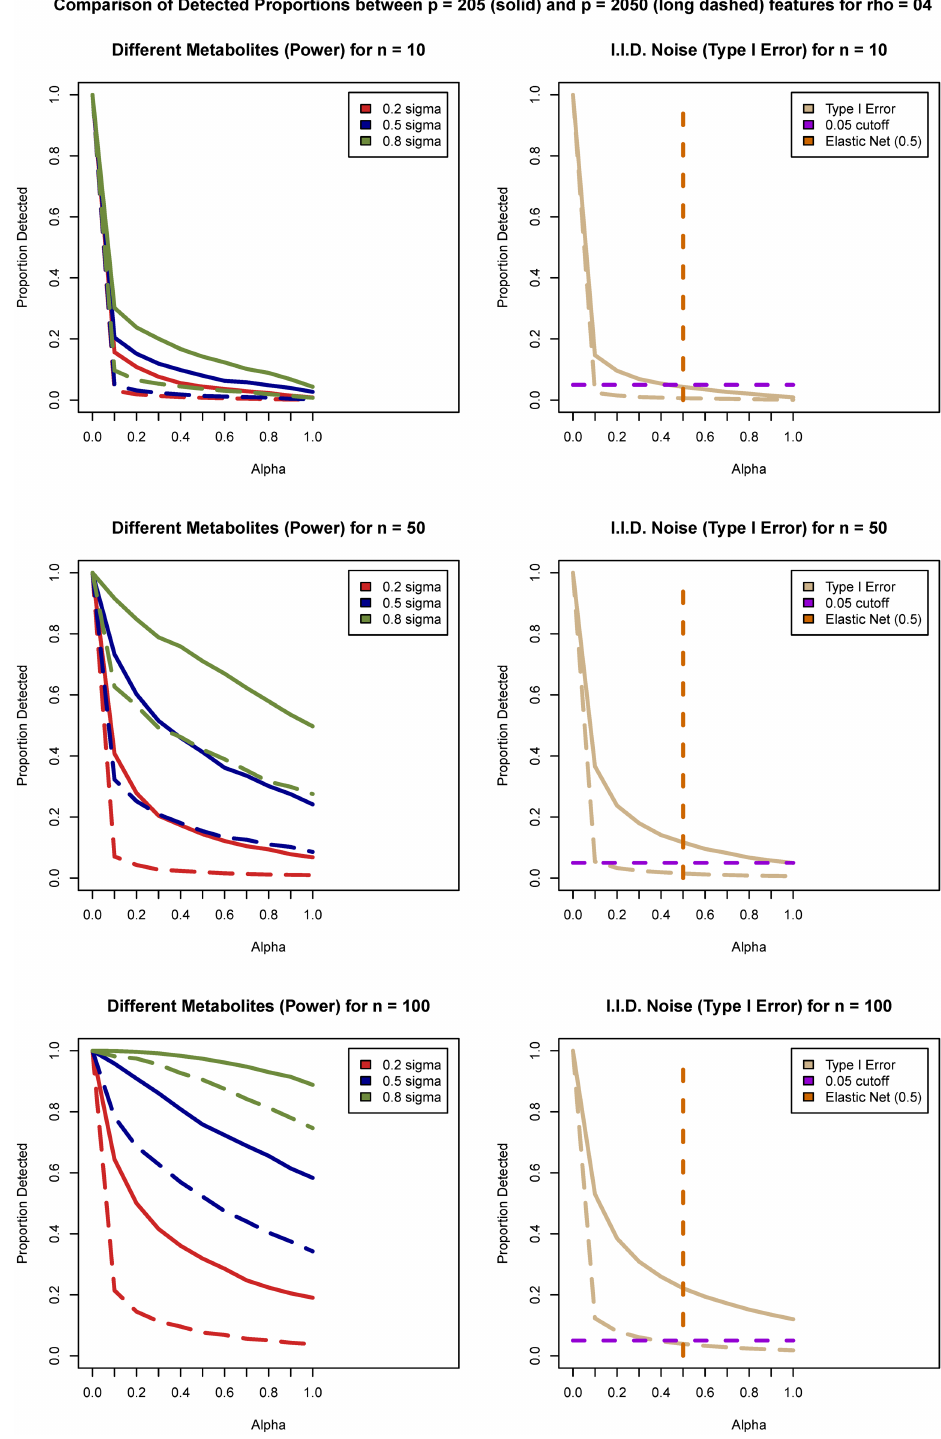
Fig 2. Visualization of power (left column) and Type I error (right column) estimates. Comparison between p = 205 (solid lines) and p = 2050 (dashed line) features for ρ = 0.8 and sample sizes n = 10 (top row), n = 50 (middle row), and n = 100 (bottom row). The value of the penalty split parameter α is plotted on the x -axis. Type I error and power estimates are plotted on y -axis for the values of α in the range of [0; 1] with 0.1 increments. In the left column power estimates are provided based on the four different features for each of the effect sizes ( Δ 1 = 0.2 is the red line, Δ 2 = 0.5 is the blue line, and Δ 3 = 0.8 is the green line). In the right column Type I error estimates are provided (beige lines)